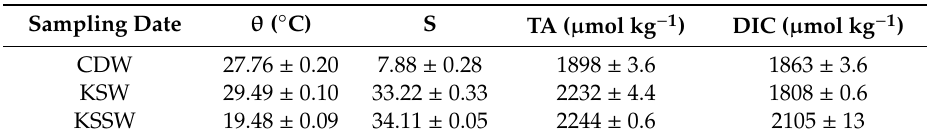
Table 2. Three end-member characteristics of water mass from measurements obtained during cruises in July and August